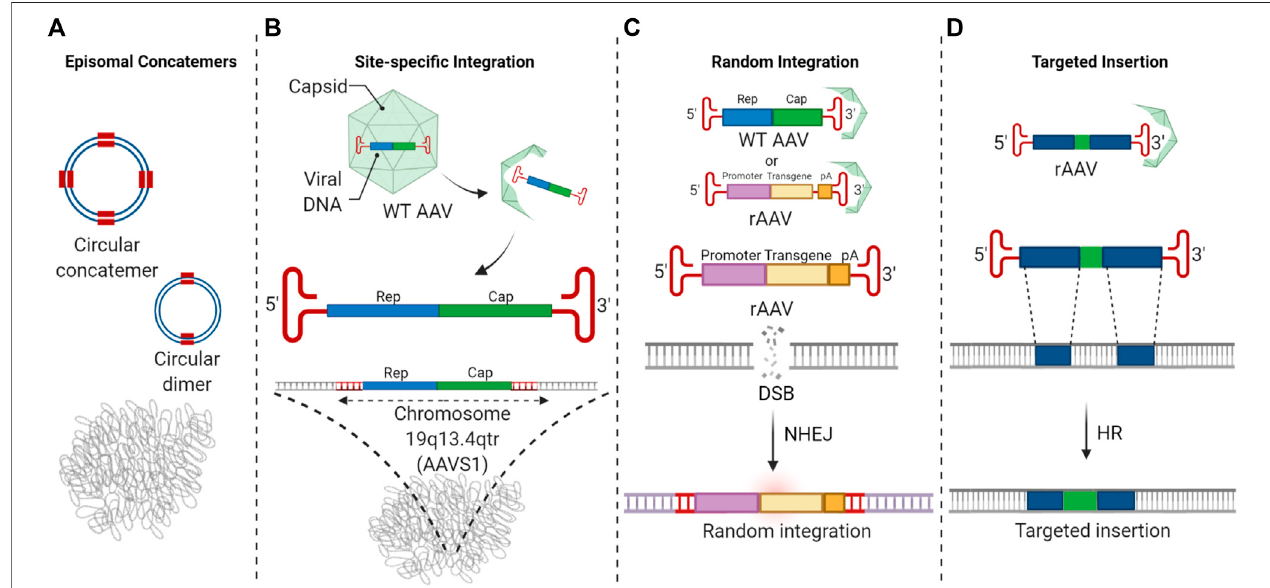
FIGURE2| ThefateofAAVvectorgenomesinthenucleus. (A) AAVvectorgenomespredominantlysurvivelong-termasepisomalconcatemers. (B) Wild-typeAAV and Rep 68/78 containing AAV vectors can undergo site-speci fi c integration at the AAVS1. (C) A small fraction of AAV vector genomes undergo random integration at very low frequencies. This event involves the AAV ITRs. (D) HR-mediated AAV editing results in targeted insertion at chromosomal locations speci fi ed by the homology